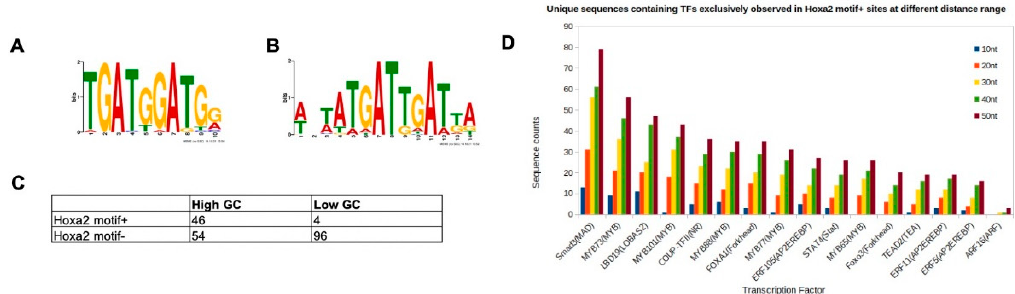
Figure 3. Properties of HOXA2 peaks containing TGATGGAT. ( A , B ) HOXA2 summits were divided in two sets on the basis of the presence of the TGATGGAT motif (motif+) or not (motif − ). Regions were sorted by decreasing GC contents (within ± 10 bp of the centre of the TGATNNAT motif) and searched for motifs in the top and last 100 GC-sorted sequences using MEME. ( A ) Regions with a higher GC content are enriched in TGATGGAT, ( B ) while regions with a low GC contain a HOX-PBX with a TG variable core. ( C ) The frequencies of TGATGGAT in the top 100 GC-high and last (low GC) 100 sites in the sorted list. ( D ) Motif occurrences in the flanking regions of motif+ versus motif − HOXA2 peaks identified by HOMER. Ratio of the number of unique sequences, for each TF, in both datasets (Hoxa2 motif+ and Hoxa2 motif − ) using different distance ranges.